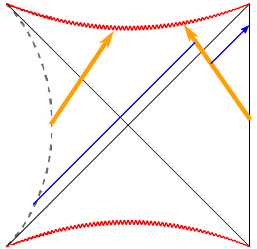
Figure 2 . Perturbations of H CFT by state-dependent operators can create negative energy shock- waves (yellow), which allow a probe from the left region (blue) to get detected by simple operators in the